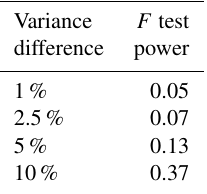
Table 2. F test power for several hypothetical percentage differ- ences between input and output